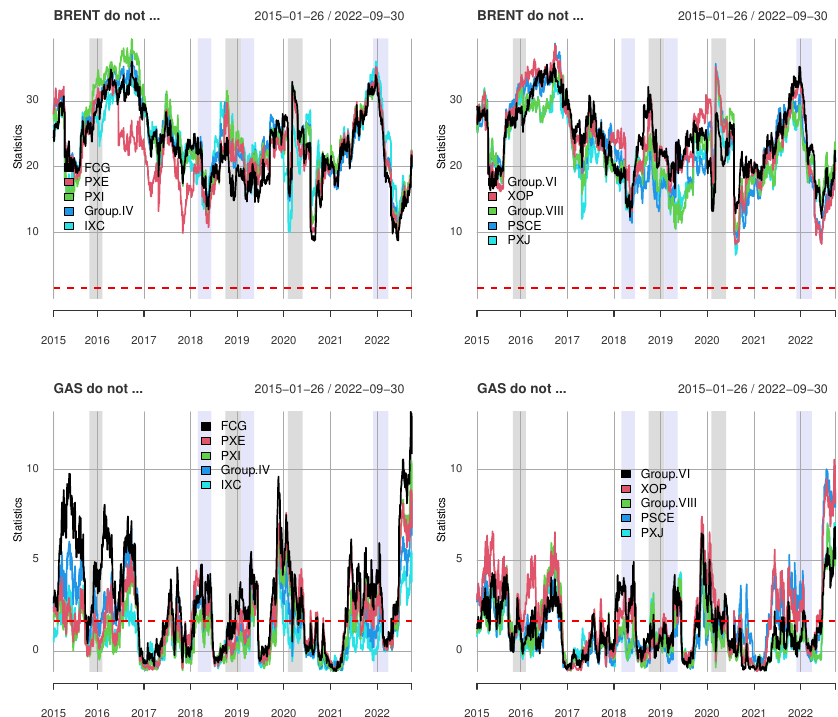
Figure 3. Rolling Hong tests between crude oil, natural gas and ETFs (causality-in-mean). Null hypothesis: BRENT/GAS do not instantaneous Granger-cause . . .. The red dashed line indicates the critical value of the H 3 test at the 5% significance level.